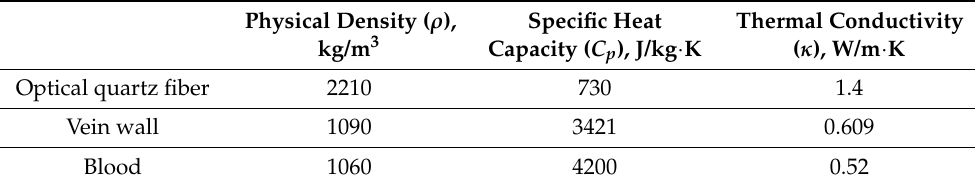
Table 1. Thermophysical parameters of optical quartz fiber, vein wall, and blood. Physical Density ( ρ ), kg/m 3